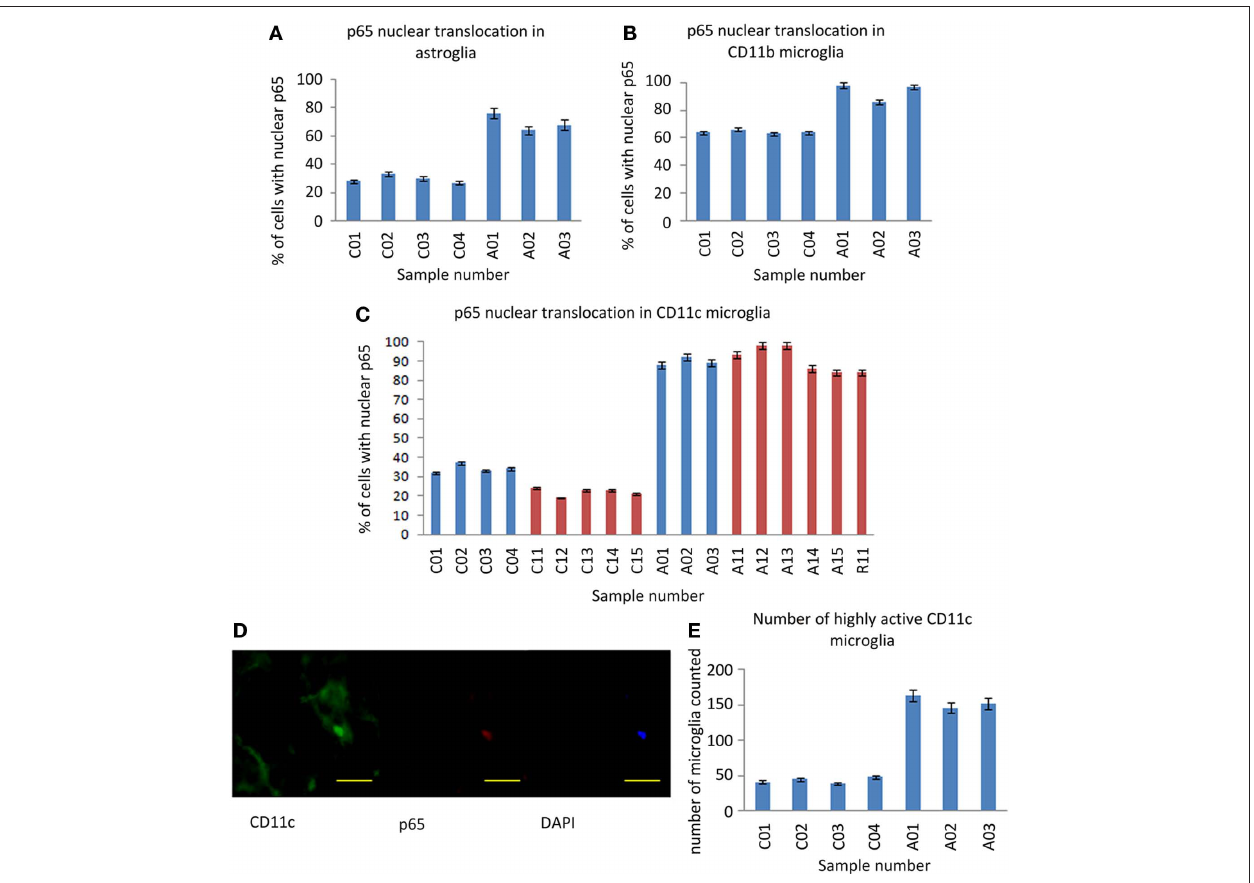
with anti-CD11c (green), anti-p65 (red), and DAPI (blue). Scale bar = 20 μm. (e) The number of CD11c positive microglia found in 20 fields of random sampling. Blue bars represent samples from the UK cohort, red bars samples from the US cohort. Sample IDs prefixed “A” are from ASC donors, prefixed “C” from control